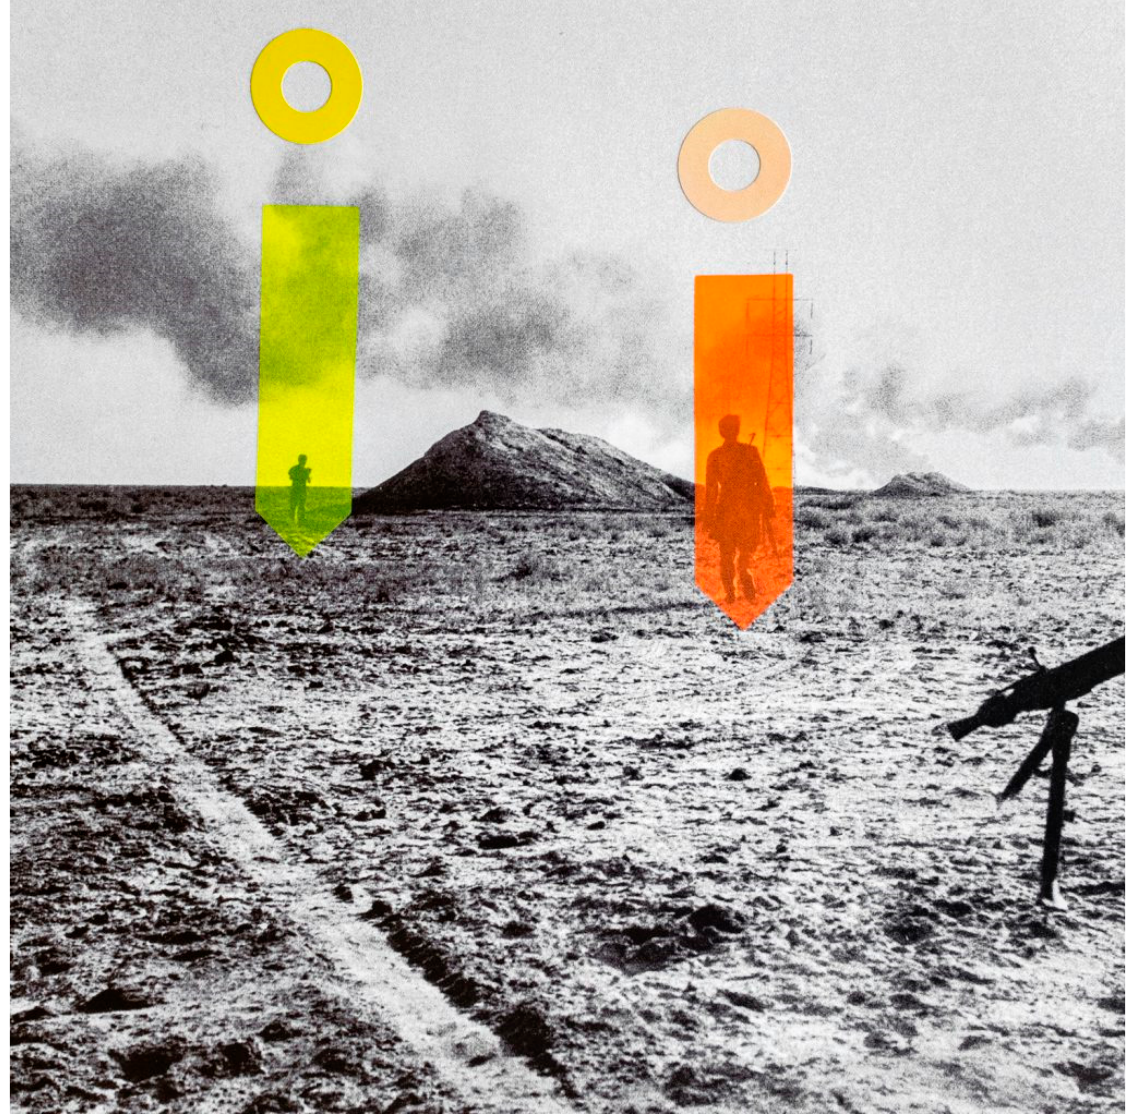
Figure 5. Parham Taghioff, From the Asymmetrical Authority series, 2018, photographs, HD inkjet print on archival acid-free paper, 50 × 50 cm.